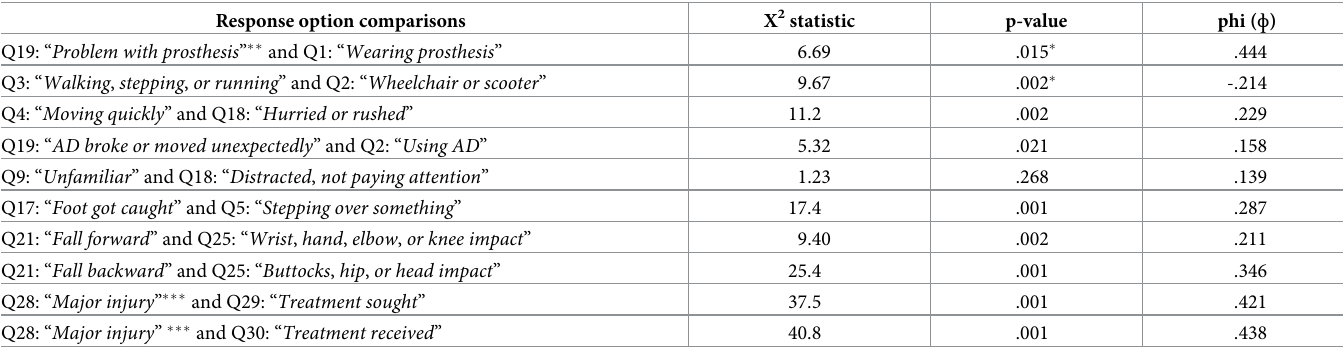
Table 4. Expected associations between response options endorsed by study participants reporting a significant fall-related event in the past 12 months (n = 212). Response option